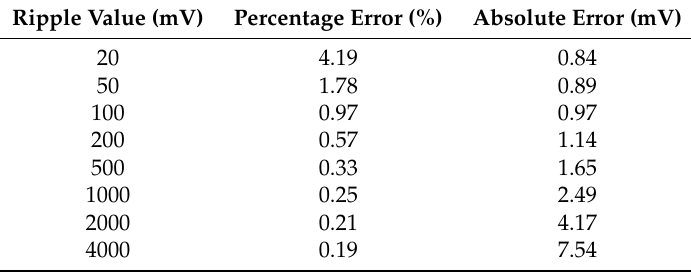
Table 2. The theoretical measurement errors in different